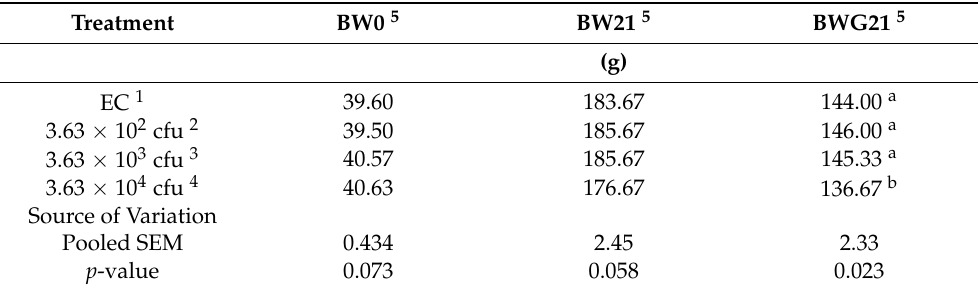
a,b Treatment means within the same variable column with no common superscript differ significantly ( p ≤ 0.05). 1 At 18 doi, embryonated eggs injected with Marek’s diluent were incubated in the same hatcher with